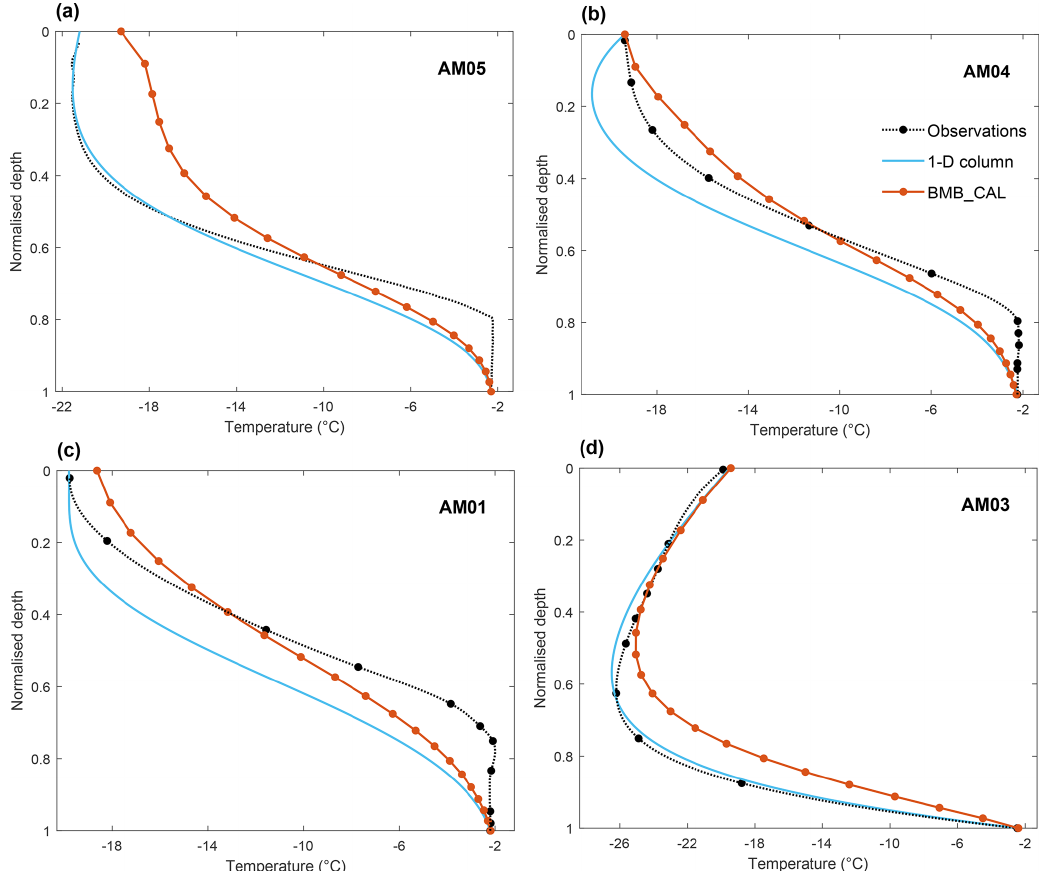
Figure 10. Normalised-depth comparisons of temperature profiles from borehole observations, 1-D column simulations and 3-D simulations. AM05, AM04 and AM01 are on the JP flowline from upstream to downstream, while AM03 is on the AM03 flowline. The 3-D model has 20 layers in the vertical, with circles indicating nodes. There are 100 layers in the column model, so individual nodes are not